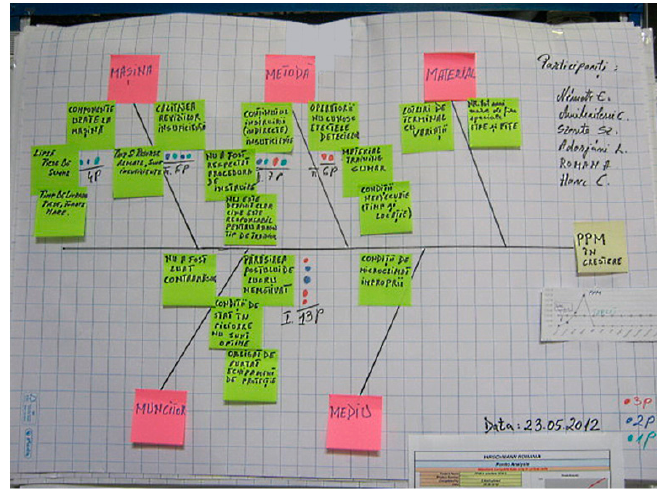
Figure 7. Analysis of the deviation from the allowed limit.